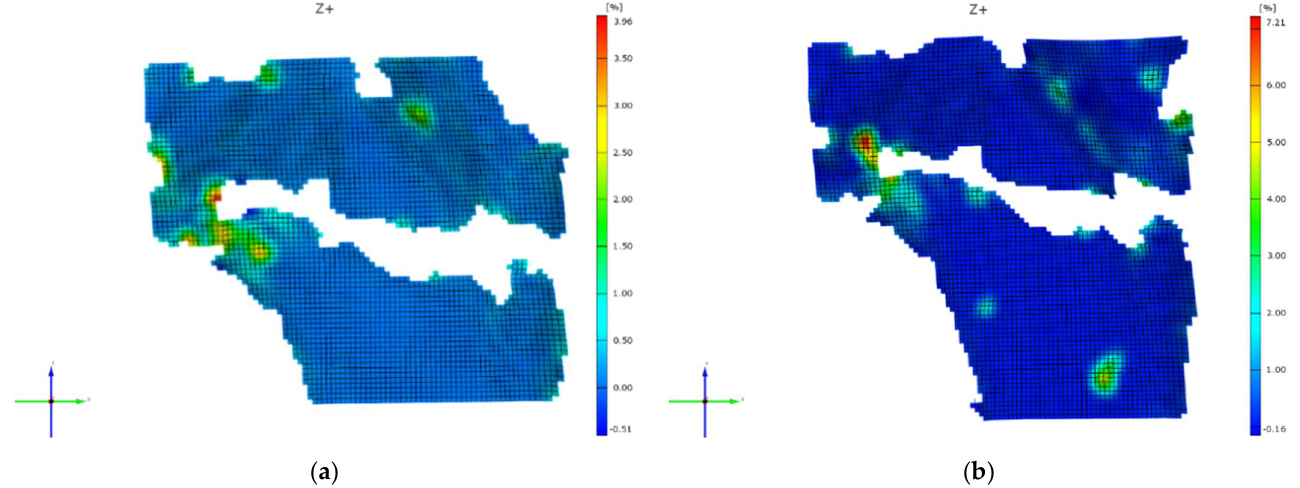
Figure 8. Values of the major strain ε 1 during Fujisawa point loading ( a ) and medial loading ( b ).